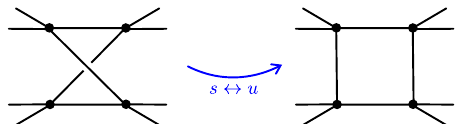
Figure 10: Crossing s ↔ u channels relates the Landau curve of the middle sub- graph of (Blue) in figure 9 with the curve of a simple box diagram. To each external vertex a bubble is connected, which is equivalent to considering 2 → 2 scattering of particles with mass 2 m